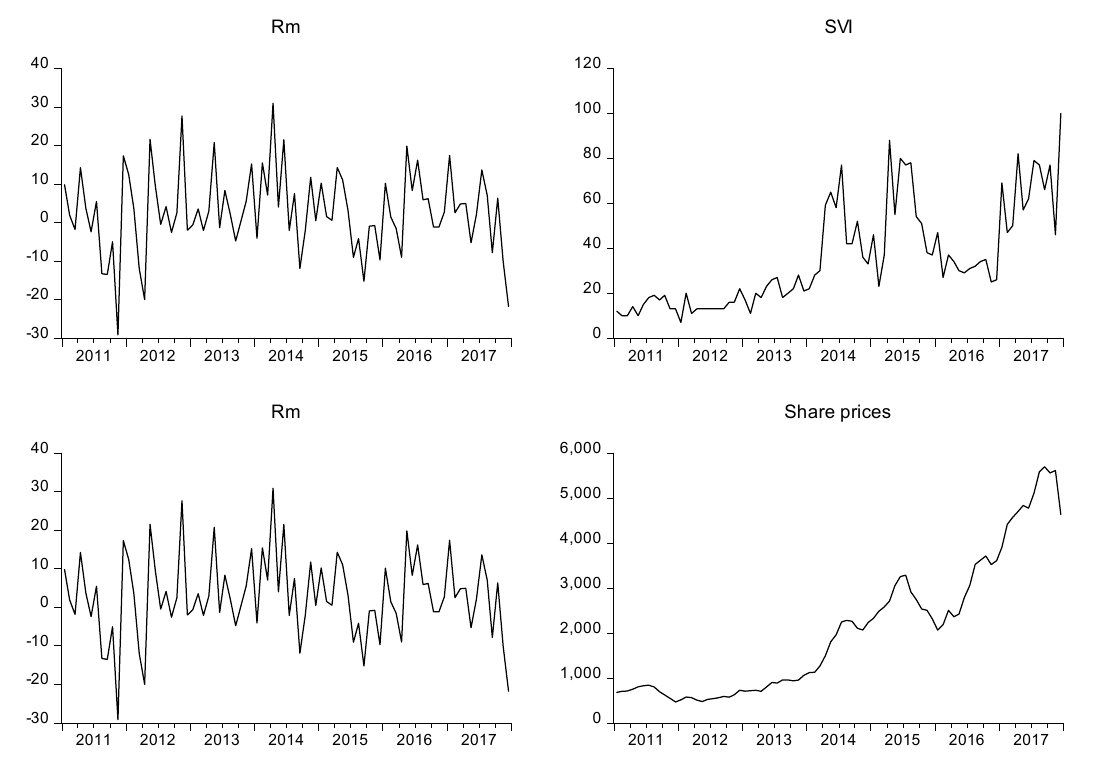
Figure 2. Rm is the market index; Share prices are the stock price; SVI is the search volume index.